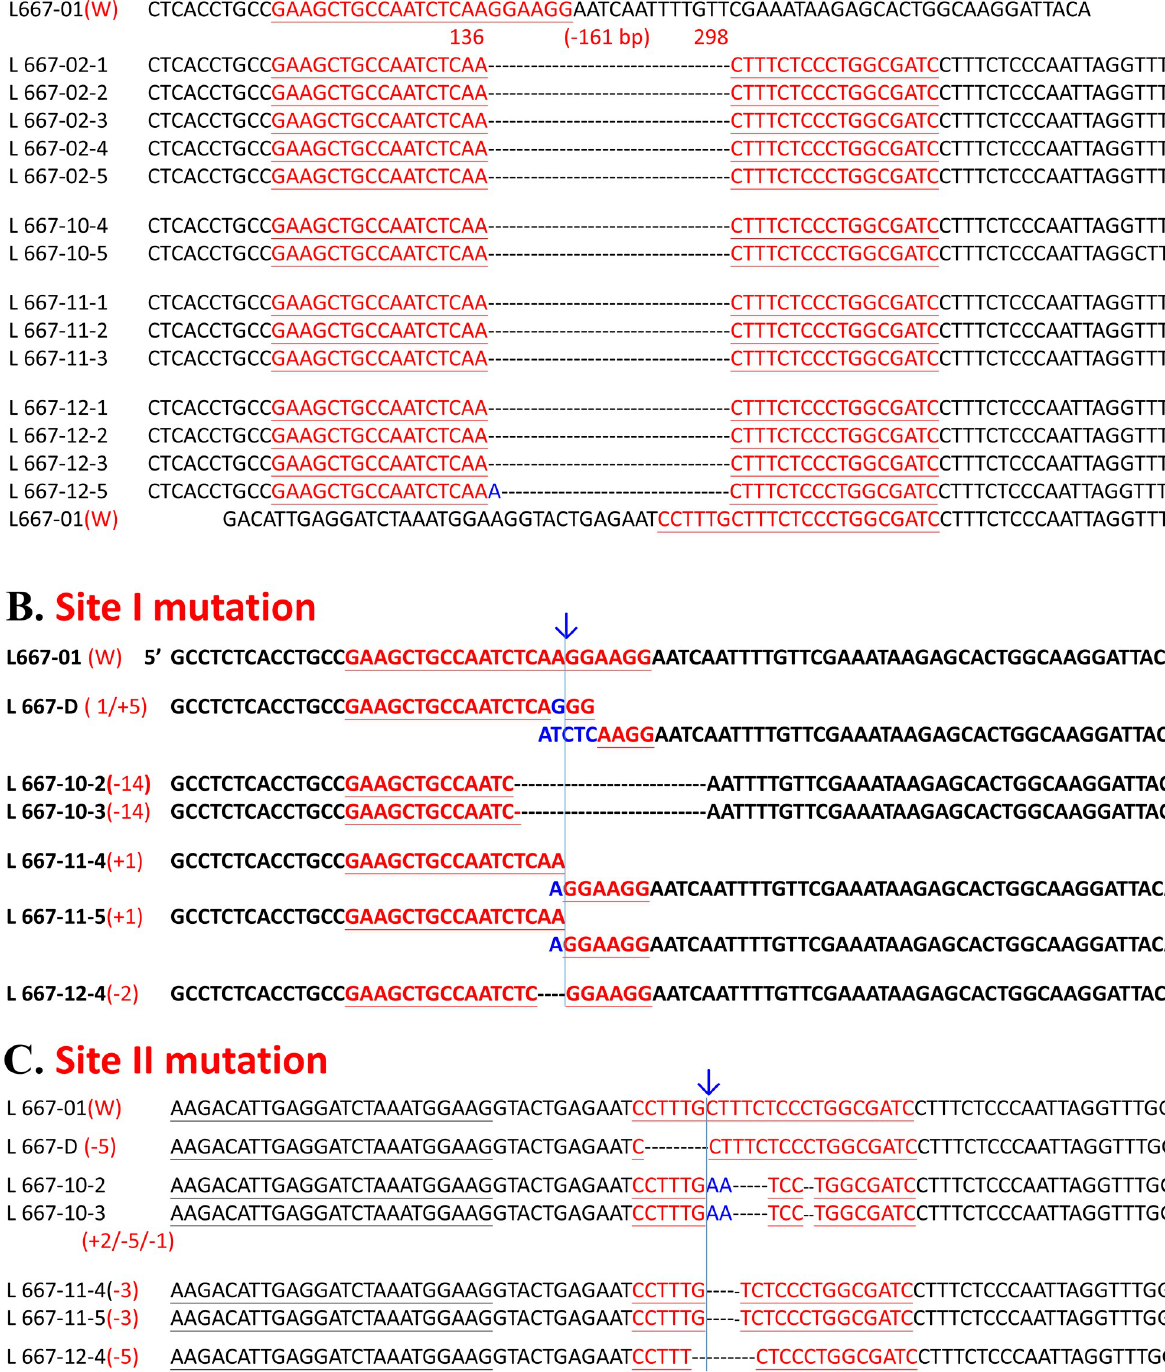
PLOS ONE | https://doi.org/10.1371/journal.pone.0217236 May 29,